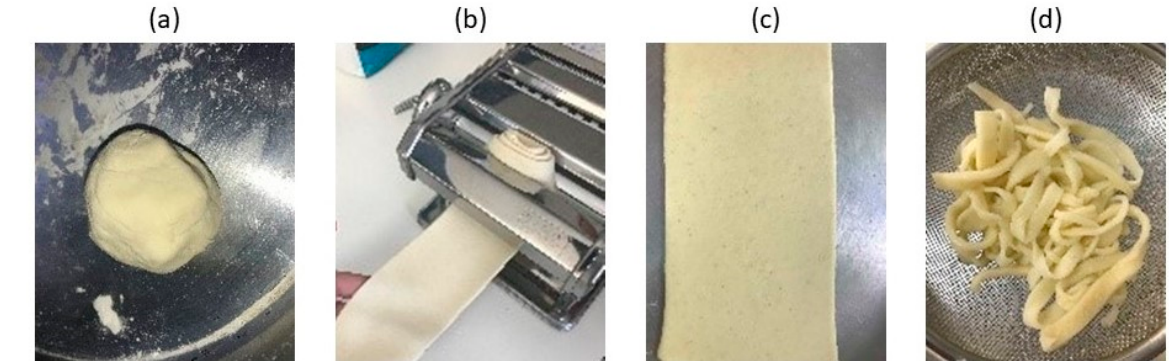
Figure 1. Pasta preparation: ( a ) dough obtained after mixing the ingredients; ( b ) shaping of the pasta; ( c ) shaped pasta obtained; ( d ) pasta after being cut into strips.